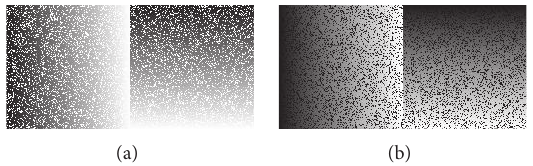
Figure 1: Example of training images for classification. The added impulse noise is 20%. (a) Training image to detect white pixels; (b) training image to detect black pixels.